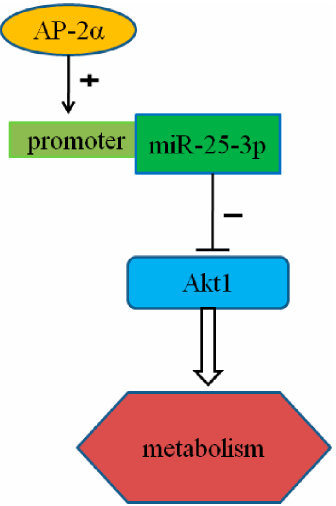
Figure 6. Representation of the proposed mechanism. miR-25-3p is regulated by transcription factor AP-2 α , and contributes to C2C12 metabolism by targeting Akt1 . The arrow-head and “+” represent activation while the blunt-head and “ − “ represent suppression.